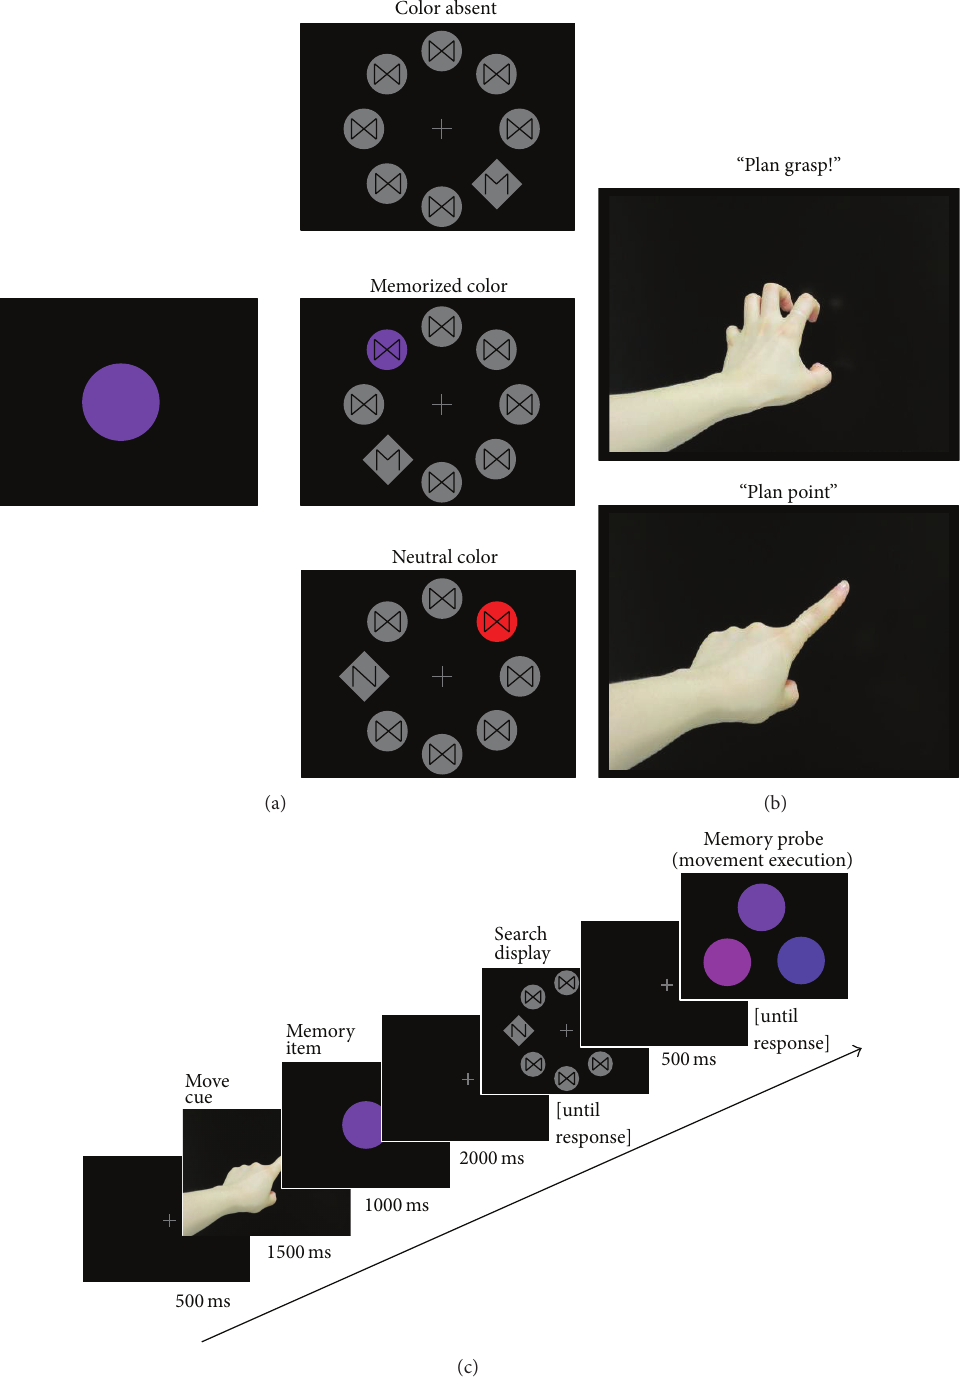
Figure 1: (a) shows the three color conditions used in the present study. The memory item was a centrally presented filled circle (left side) that had one out of thirty-six color hues. Participants had to remember the hue until the end of a trial. In the search task (right side), participants had to report the letter (“ 𝑀 ” or “ 𝑁 ”) embedded in the grey diamond-shaped target. Distractors had an embedded tilted hourglass. In the “color absent” condition all distractors were grey. In the “memorized color” condition, one of the distractors had a hue from the same color category as the memory item previously shown. In the “neutral color” condition, one of the distractors had a hue from another color category. (b) shows the movement cues. When a grasping hand was shown, participants had to plan a grasping movement (upper picture). When a pointing hand was shown, participants had to plan a pointing movement (lower picture). Execution of the movement had to be withheld until the end of the trial. (c) shows a trial procedure. Participants had to plan a movement (move cue) and remember a color hue (memory item) while performing a visual search task (search display). After search was completed, participants had to perform the planned movement towards the colored item they thought would match the original memory